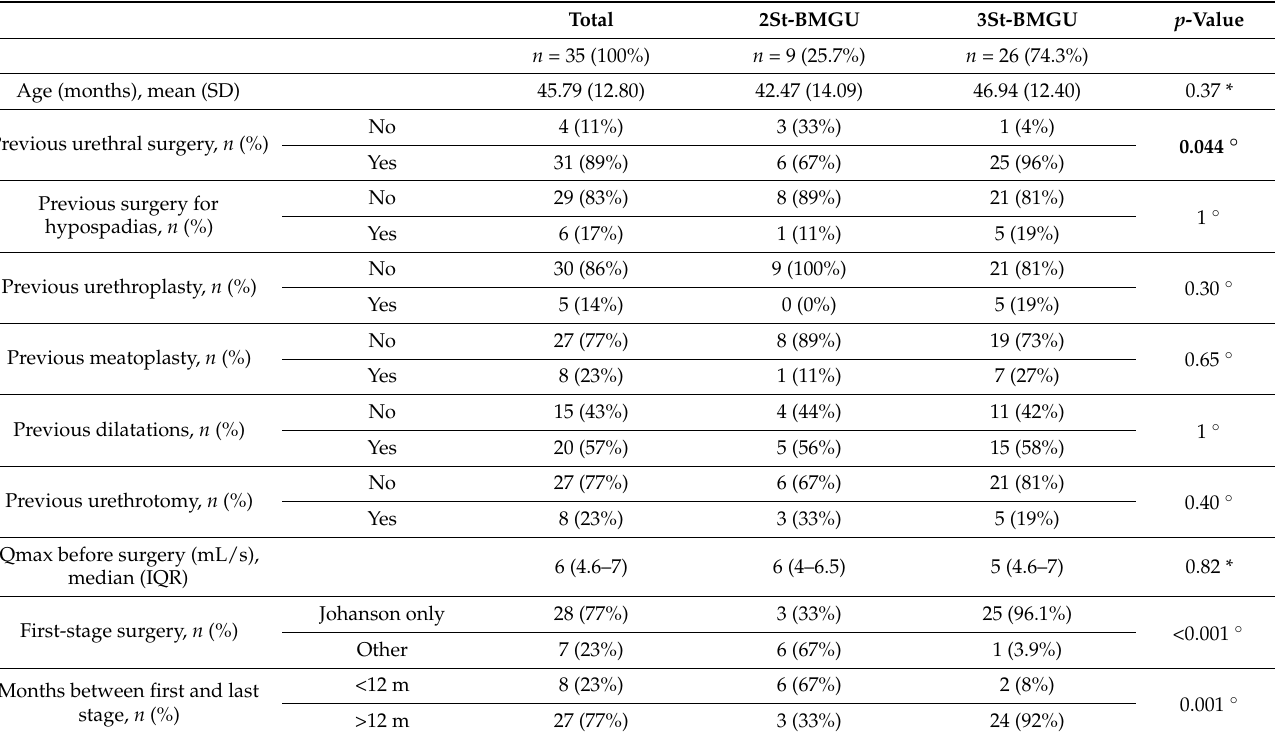
Table 1. Main characteristics of the population stratified by the number of stages. Total 2St-BMGU 3St-BMGU p